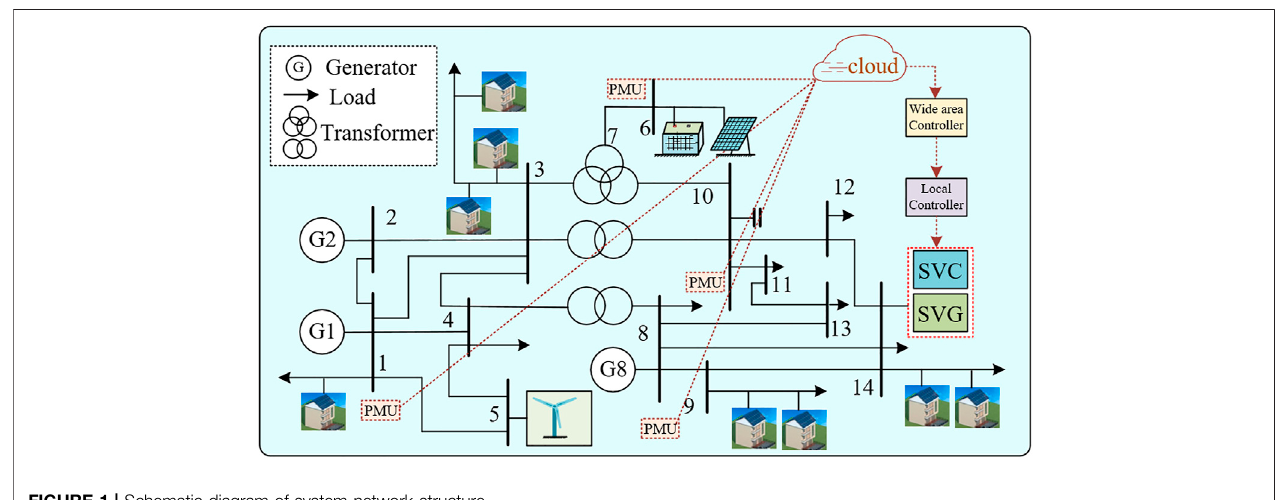
FIGURE 1 | Schematic diagram of system network structure.